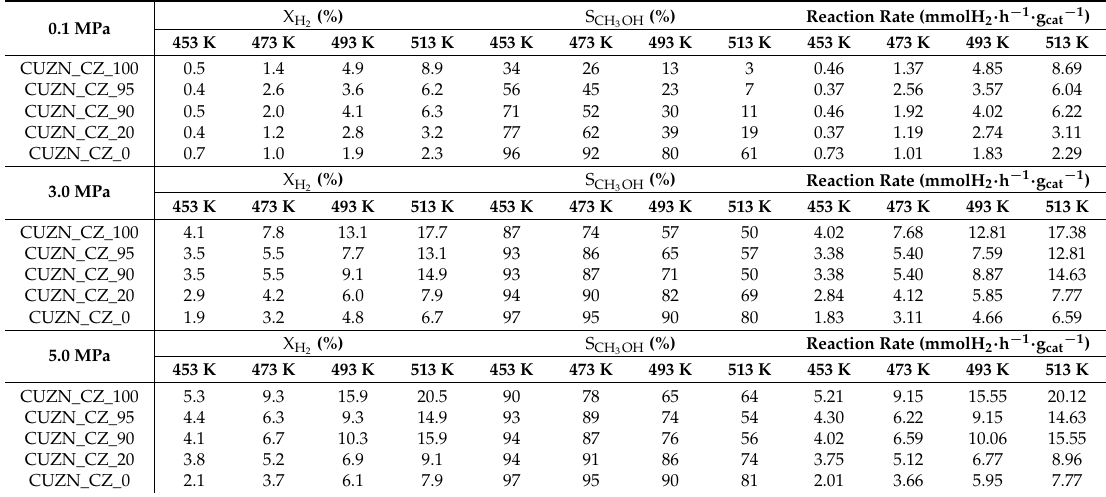
Table 2. Results of the catalytic test in the CO 2 hydrogenation at different temperature and